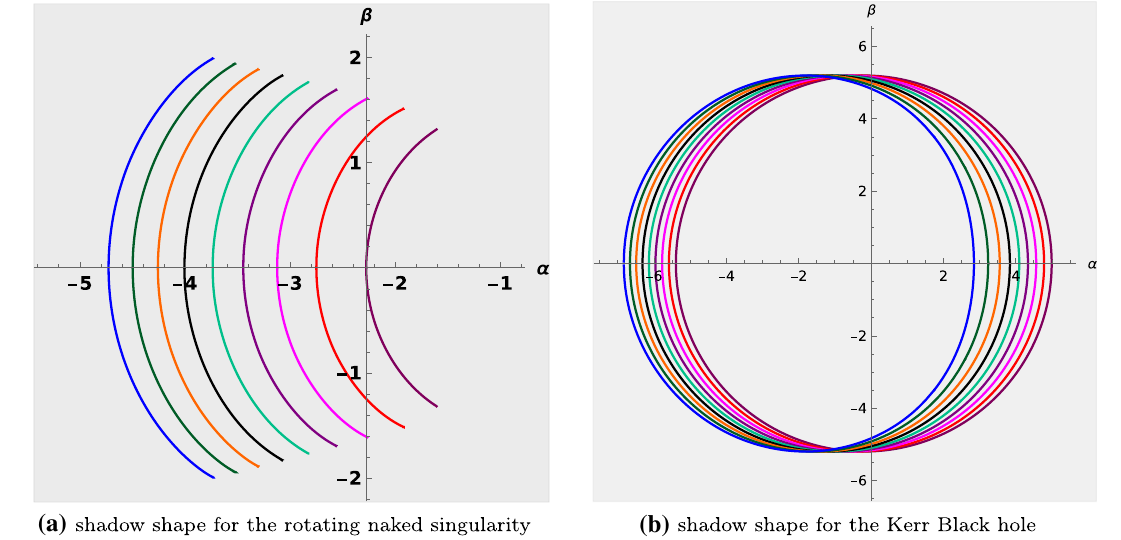
Fig. 4 The figure shows the shadow outline cast by RNS and Kerr black hole. For both cases, the value of mass is set to one. The shadow shape indicated by blue to magenta color lines is formed for the spin parameters 0.9 to 0.1. The detailed discussion of this shadow images is given in Sect.